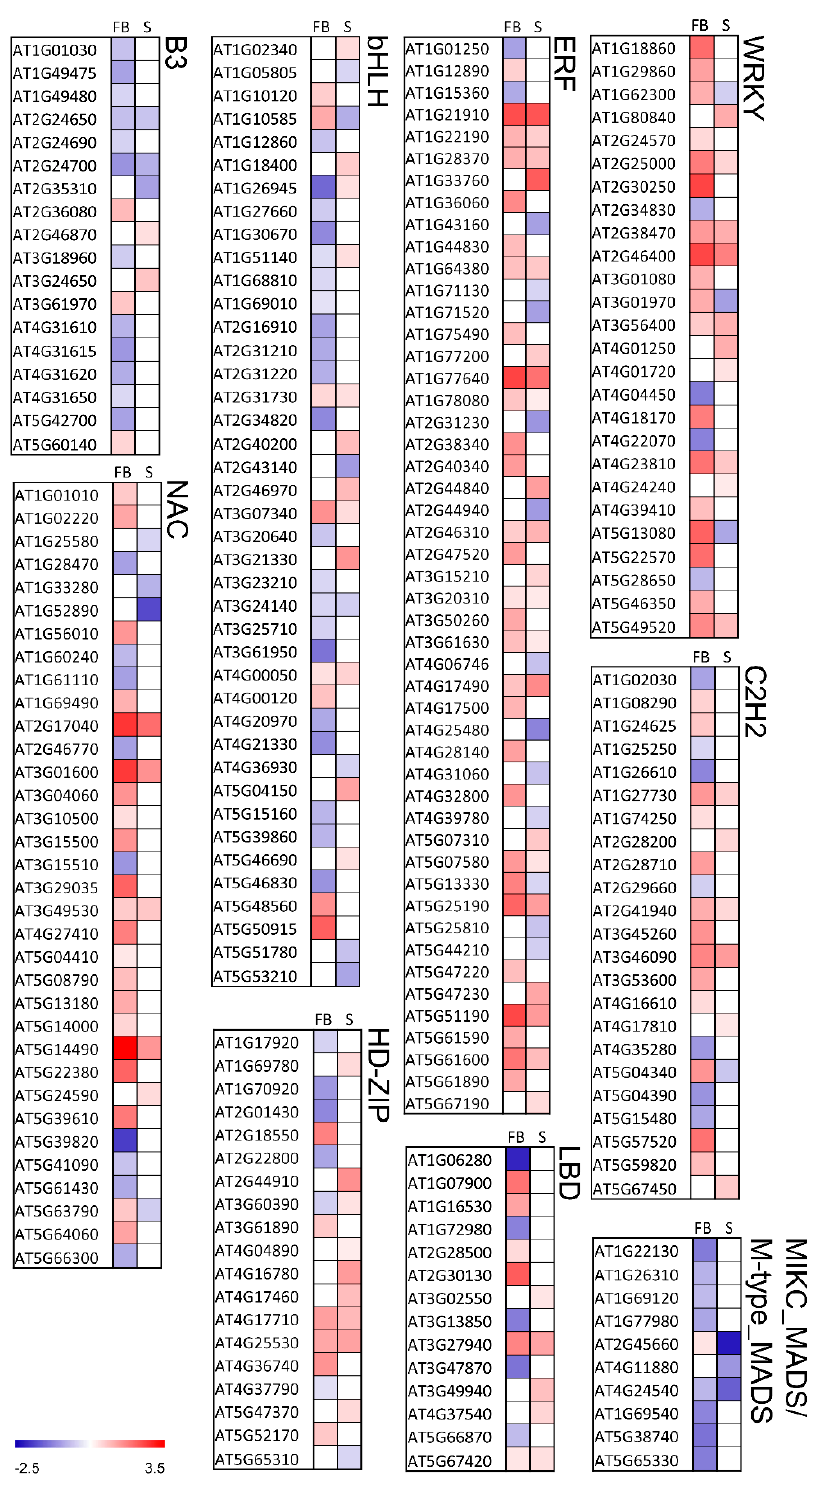
Figure 5. Differentially expressed genes encoding transcription factors in the knl2 mutant line. Expression in knl2 flower buds and knl2 seedlings is depicted as F and S, respectively. Red and blue represent up- and downregulated differentially expressed genes, respectively. All values are log 2 transformed. The gradient color illustrates the expression value.